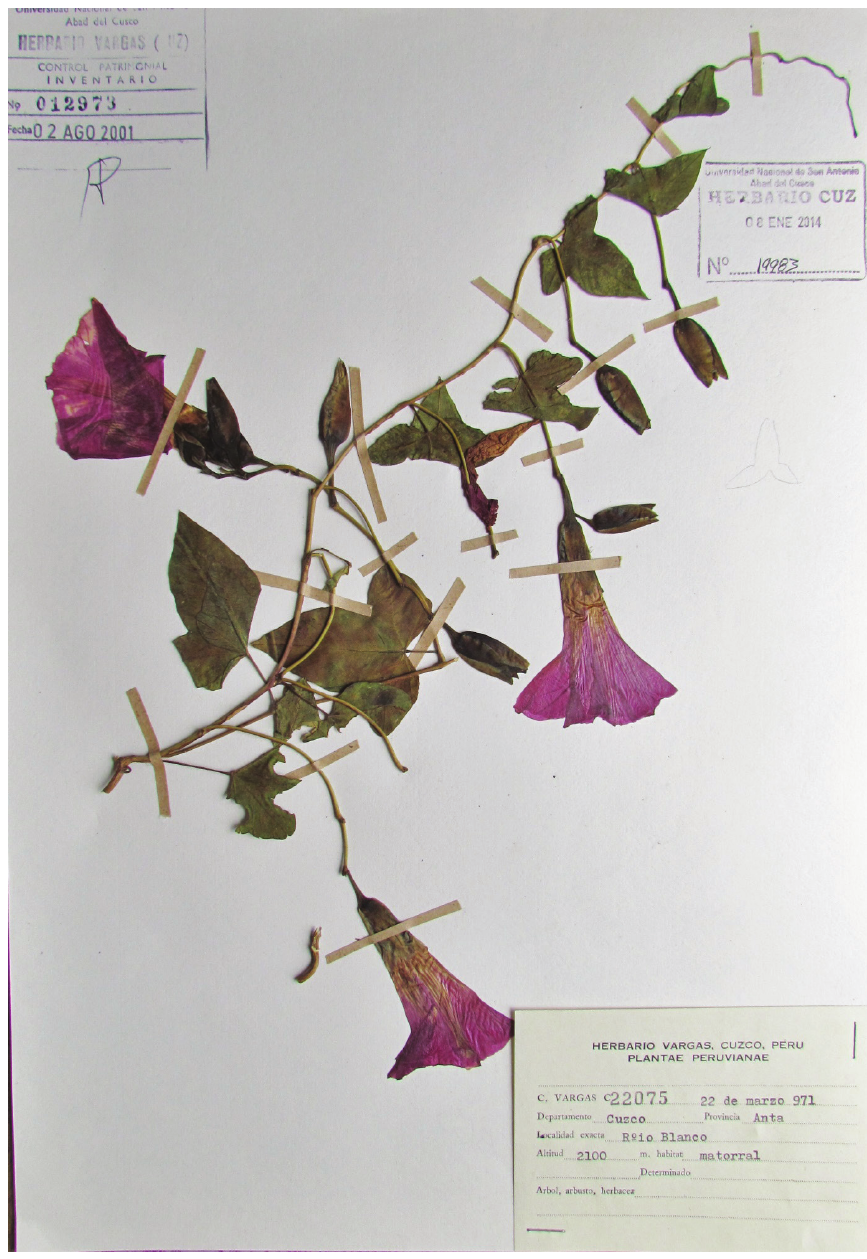
Figure 4. Image of Vargas 22075 showing the distinctive purple flowers of Ipomoea cuscoensis. Distribution and habitat. Endemic to dry forest and scrub at 2100–2700 m in Southern PERU. Figure